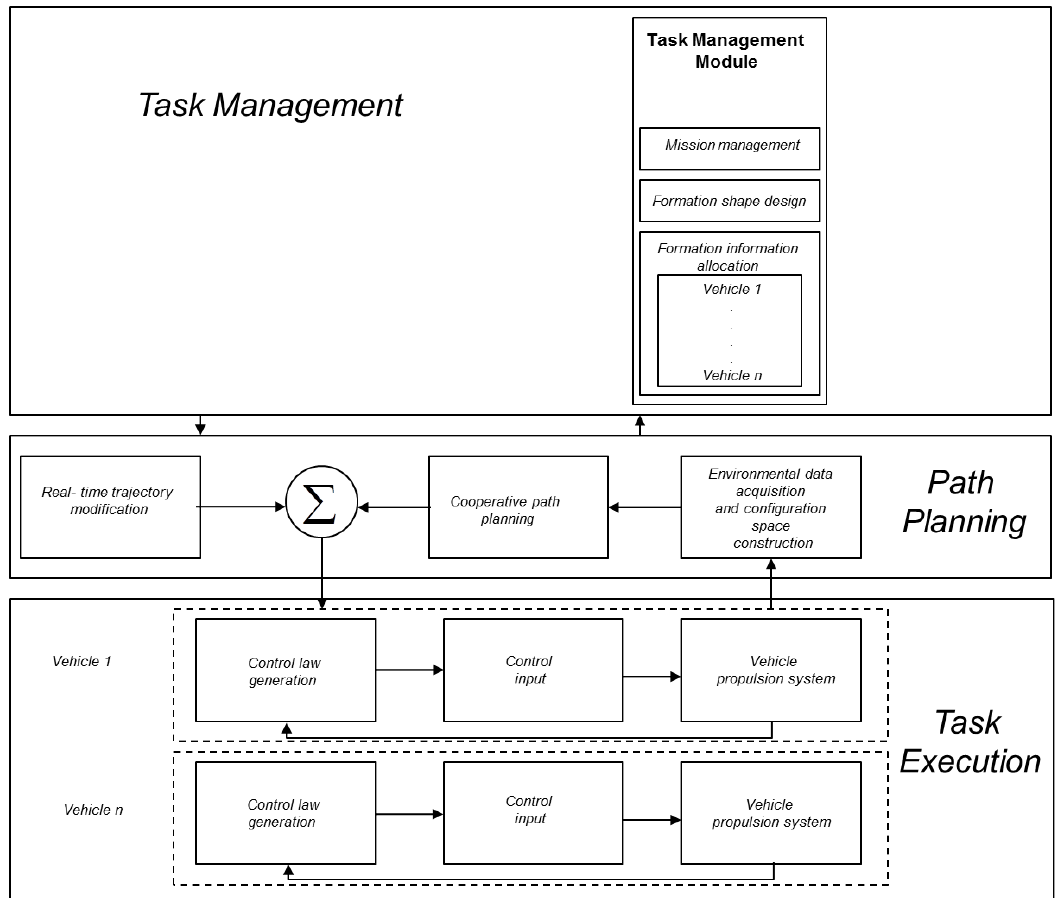
Figure 3. Generic architecture of a multiple vehicle system (Source: modified from